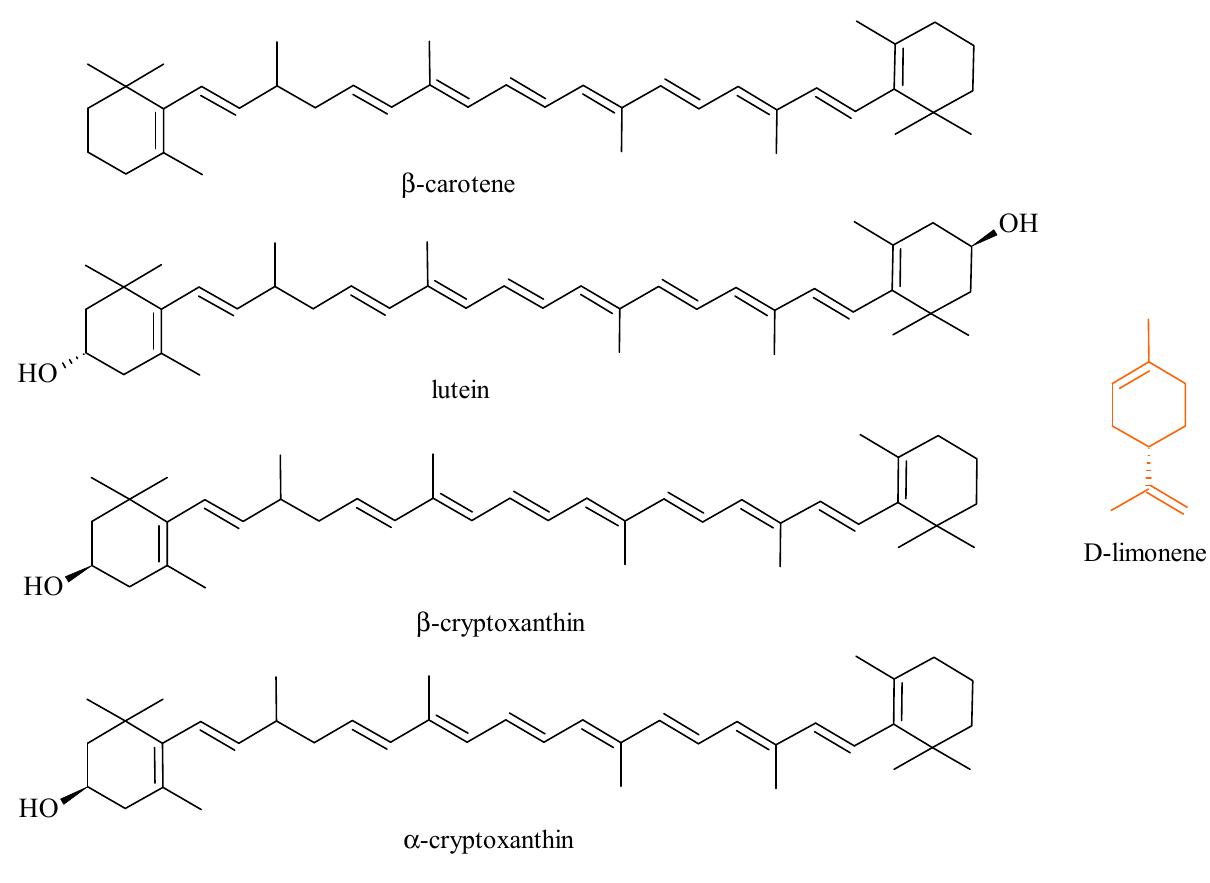
Figure 11. Structures of terpenoids identified in A. ursinum